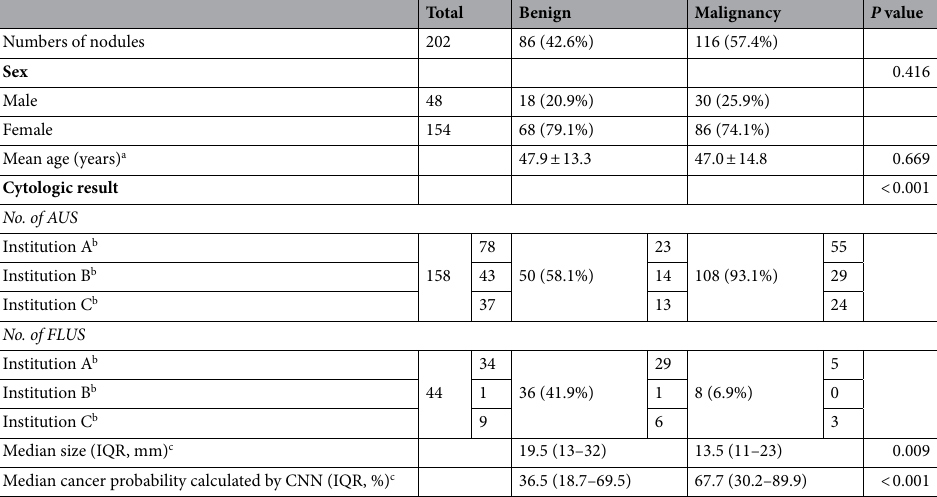
stratify the risk of Bethesda class III lesions 3,4 , US assessment is limited in application due to its inherent limita-